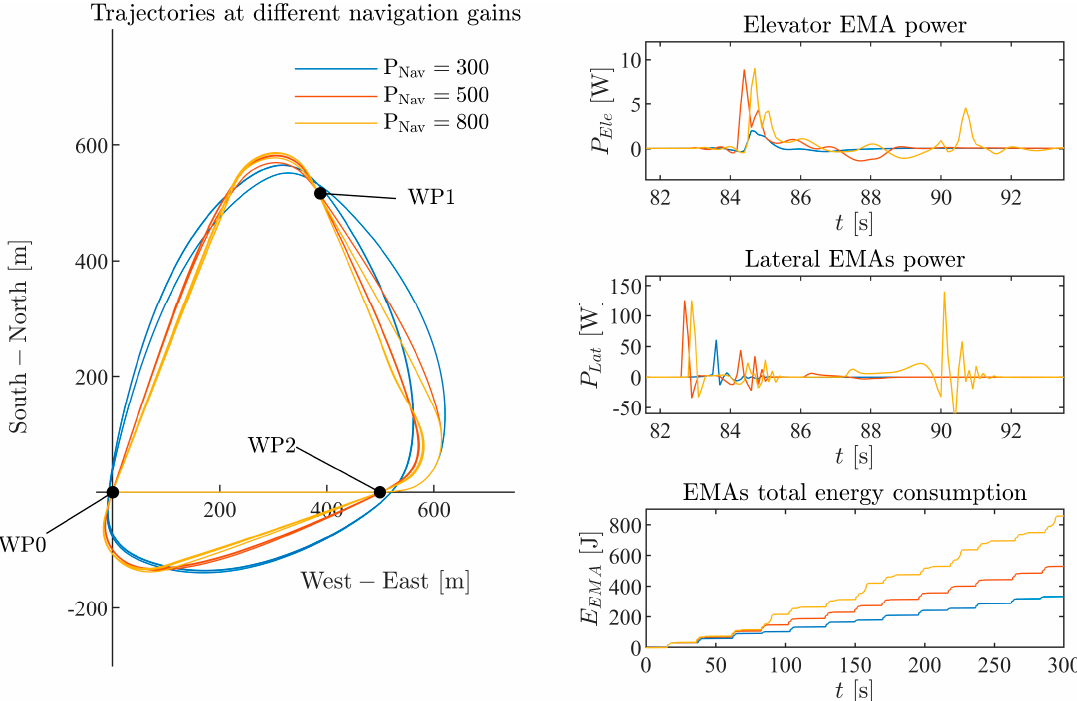
Figure 17. Trajectories and EMA power consumption of the RX-1E at different heading control gain settings.